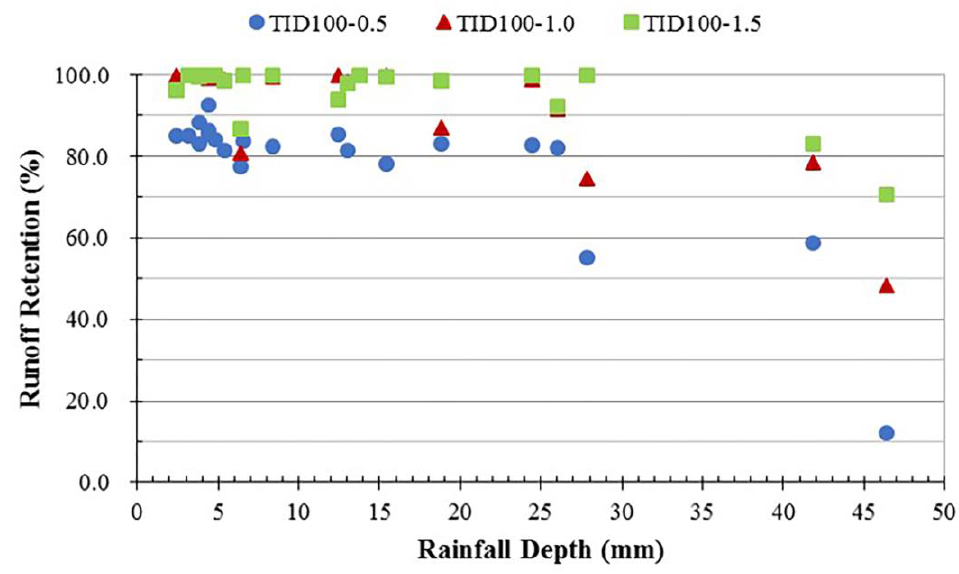
Figure 3. Rainfall retention rates R3 varying with different scale of EGR modules under 22 monitored rainfall events.